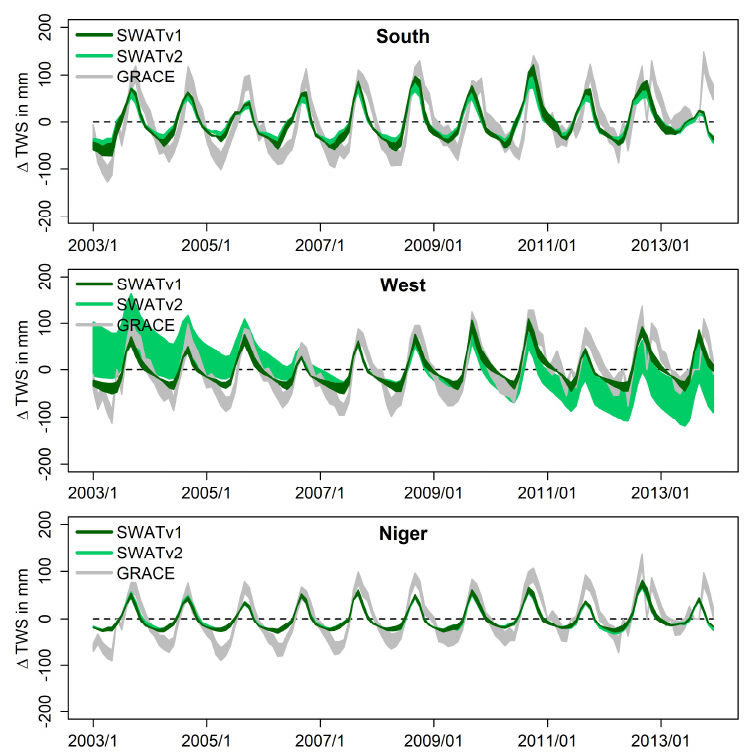
Figure 8. Monthly Simulated Total Water Storage Validation against GRACE Data, where SWAT v1 is the global and v2 the local calibration.